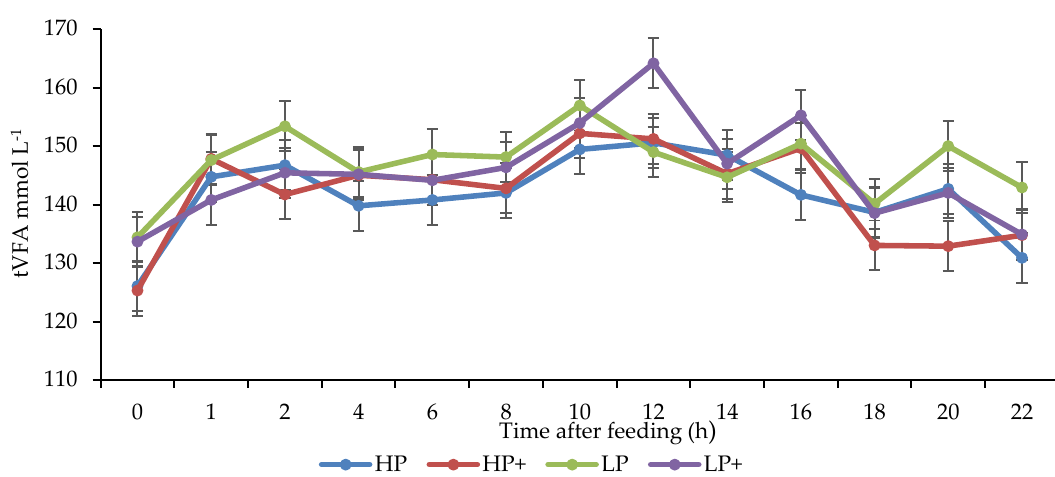
Figure 3. Effect of chitosan inclusion level and crude protein on ruminal total volatile fatty acid concentrations. Crude protein × chitosan p > 0.05; crude protein p < 0.001; chitosan p > 0.05; time after feeding p < 0.001 .